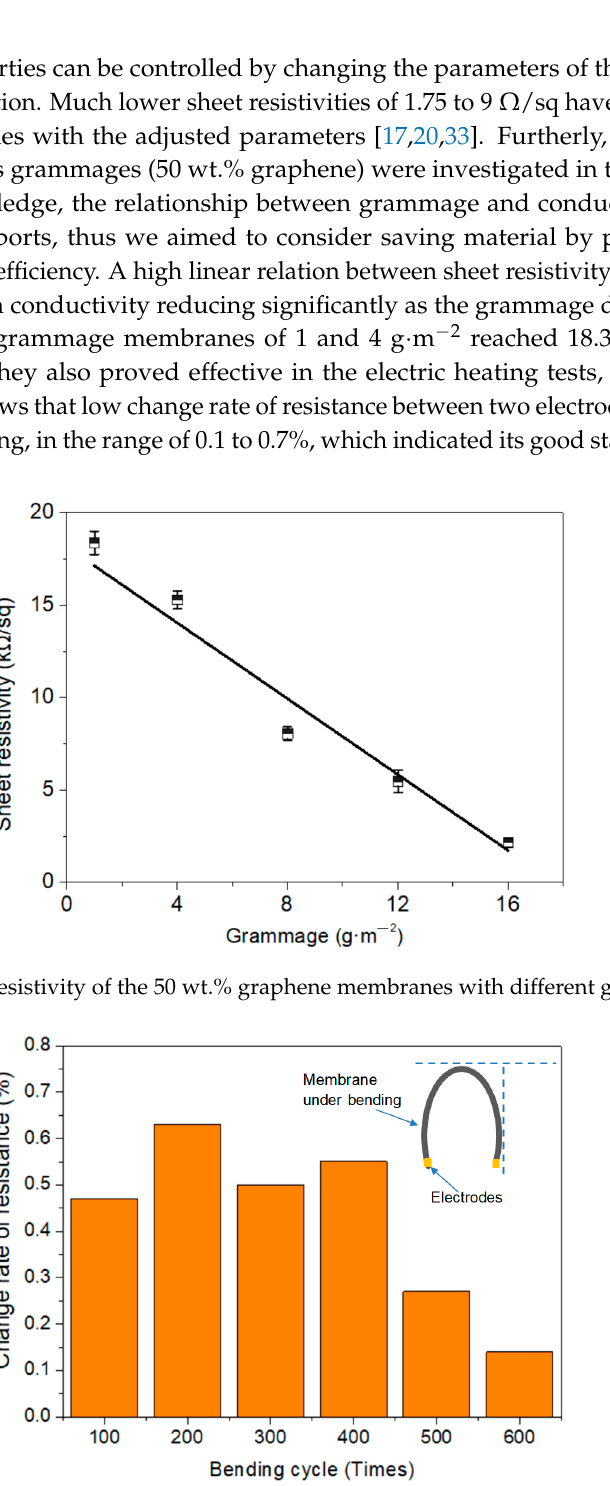
Figure 8. Sheet resistivity of the 16 g·m − 2 membranes with different amounts of graphene.